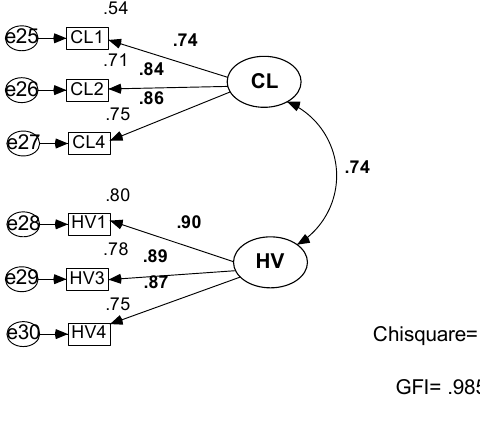
Fig. 4. CFA results on scales measuring competitive advantage of